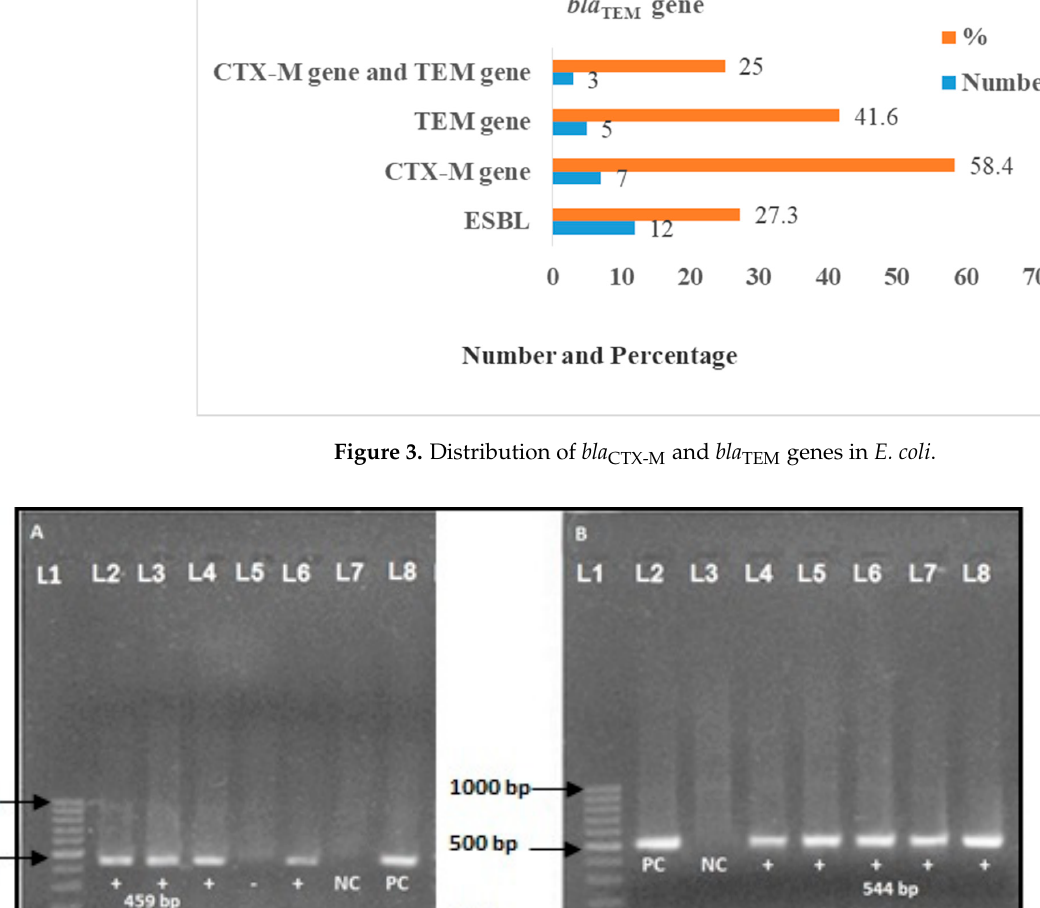
Figure 4. ( A ) bla TEM gene (459 bp) (Lane L1, marker DNA (100–1000 bp)), L2, L3, L4, L6 positive band, bla TEM gene (459-bp),